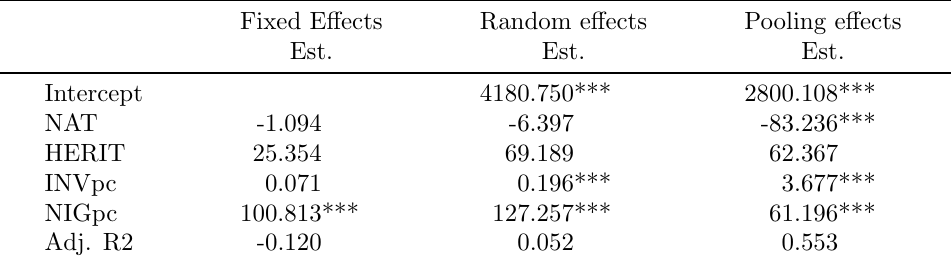
Table A.2: Alternative panel